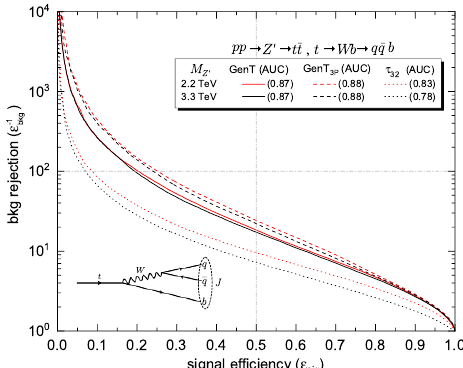
Figure 2 . ROC curves for top quark jet signals (for details see the self-explanatory legends and the main